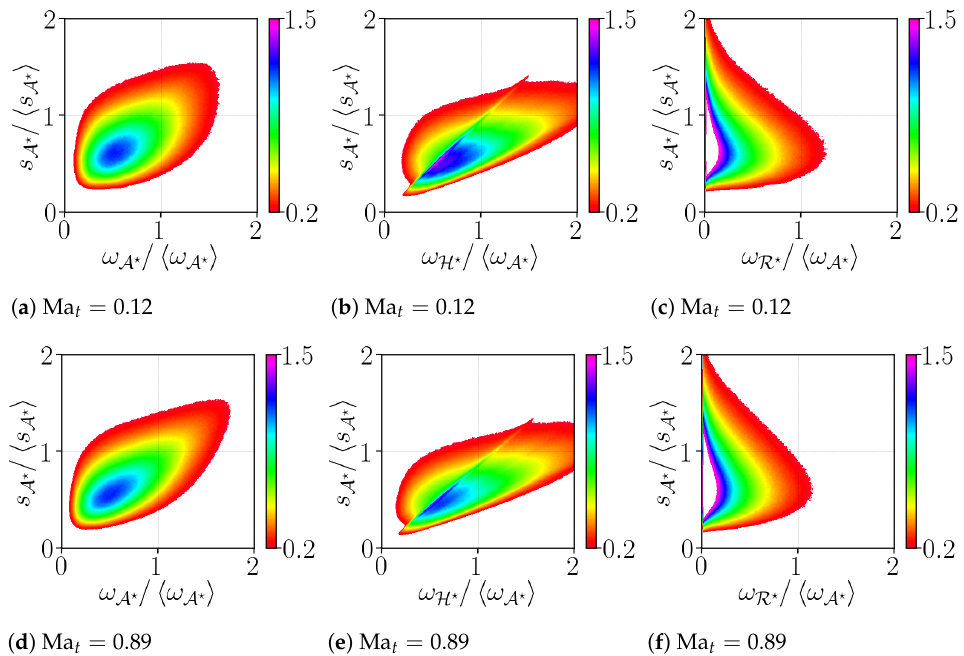
Figure 11. Joint PDF of vorticity with its components and strain rate for Ma t = 0.12 and Ma t =